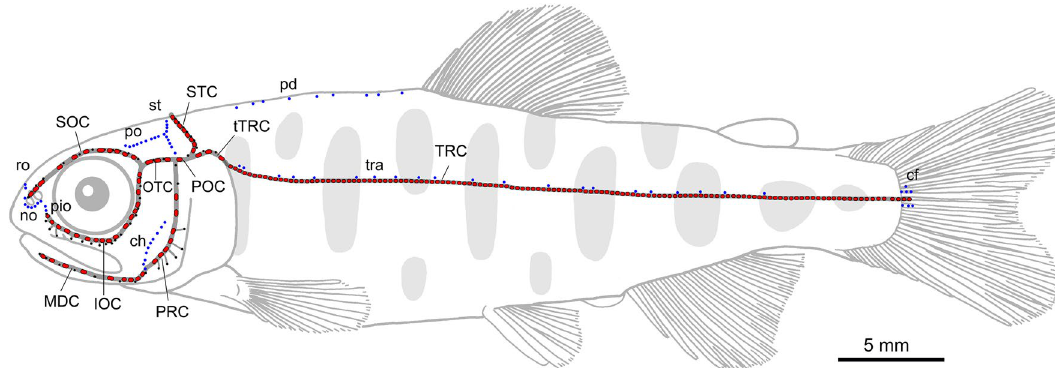
Figure 1. Lateral line system in Oncorhynchus masou masou . Dark grey, pores; grey, canals; large red dots, canal neuromasts; small blue dots, superficial neuromasts. Abbreviations of lateral line canals: IOC infraorbital